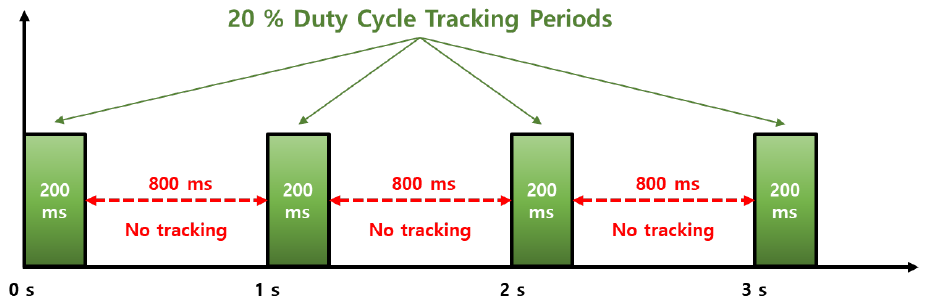
Figure 3. Duty-cycle versus time.